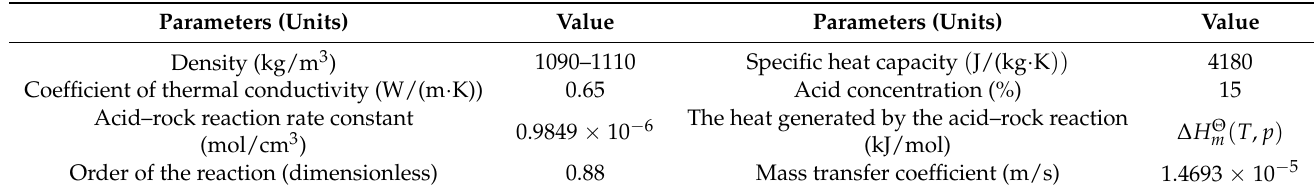
Table 2. Injection parameters for Shunbei well